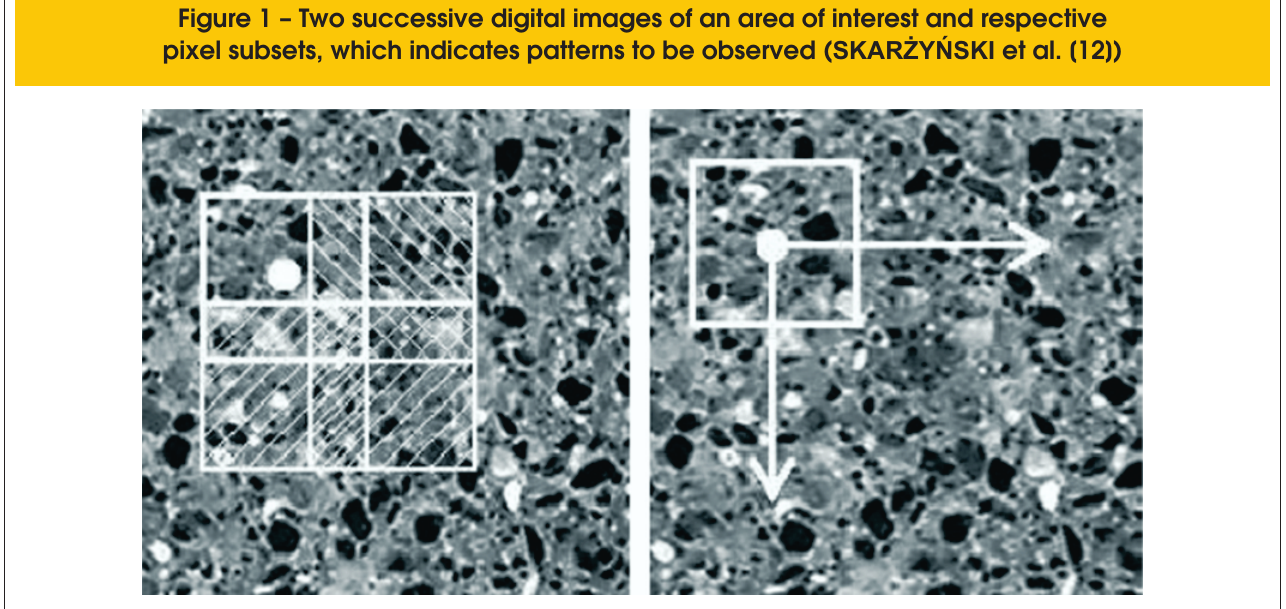
Figure 1 – Two successive digital images of an area of interest and respective pixel subsets, which indicates patterns to be observed ( SKARŻYŃSKI et al.